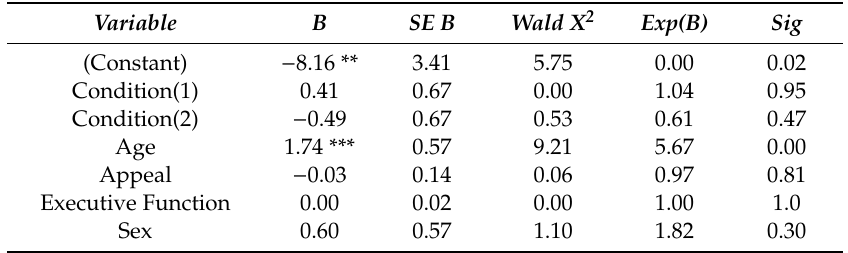
Table 3. Logistic Regression Results for Transfer Task 2; Correctly Making the Grey Side of the Scale Heavier.